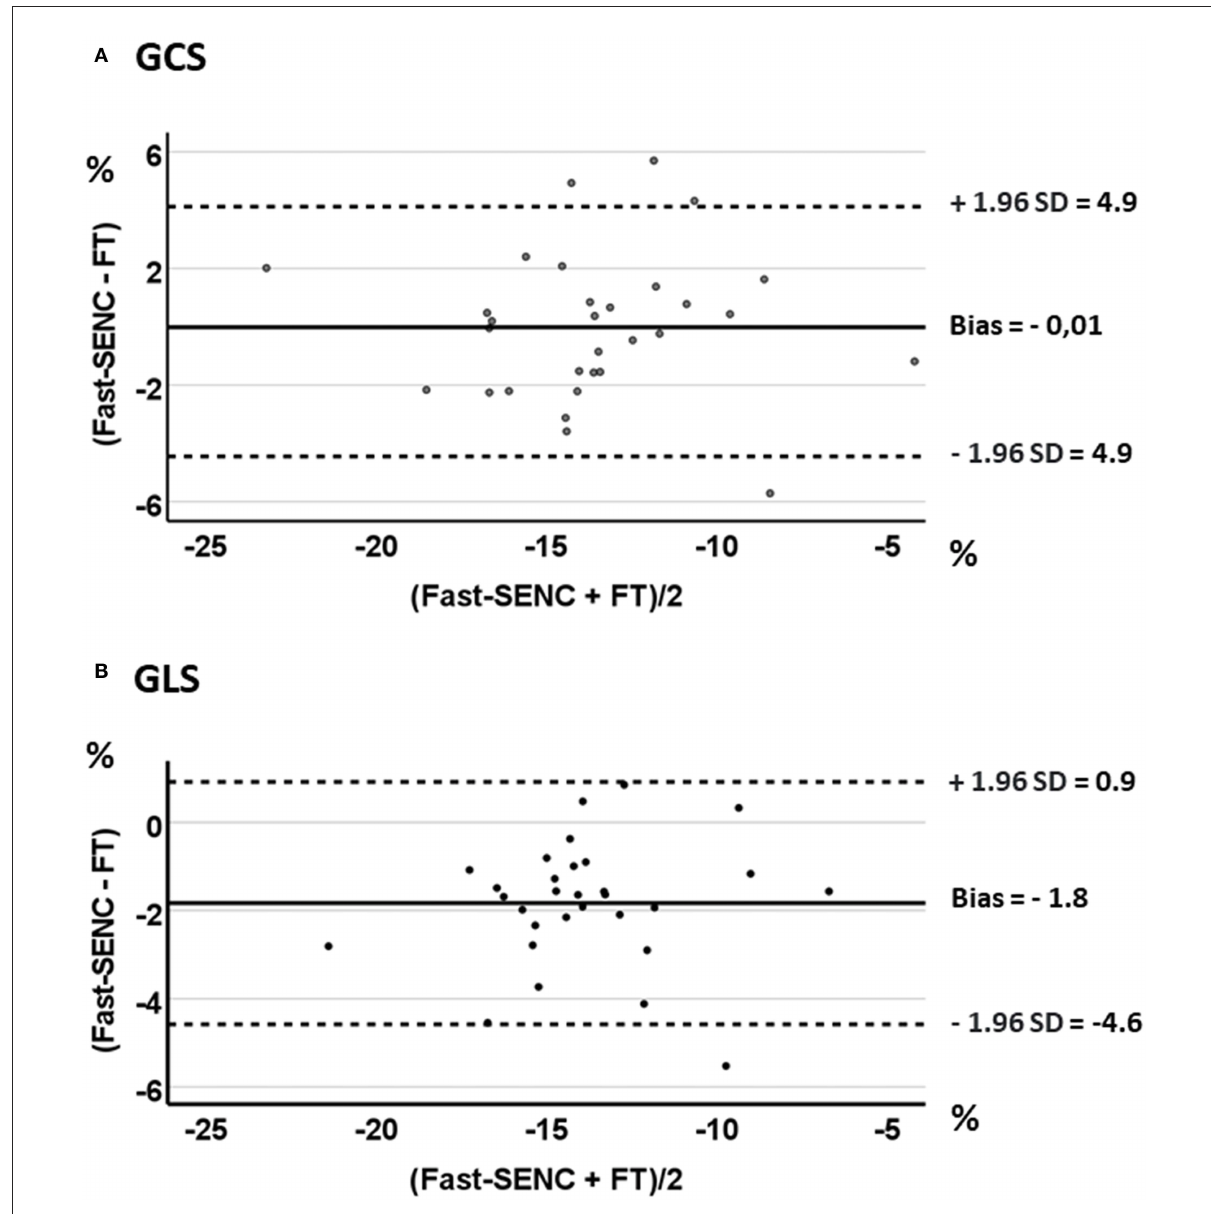
FIGURE5 Bland-Altman plots with limits of agreement (1.96 SD) for fast-SENC and FT for GCS (A) and GLS (B)